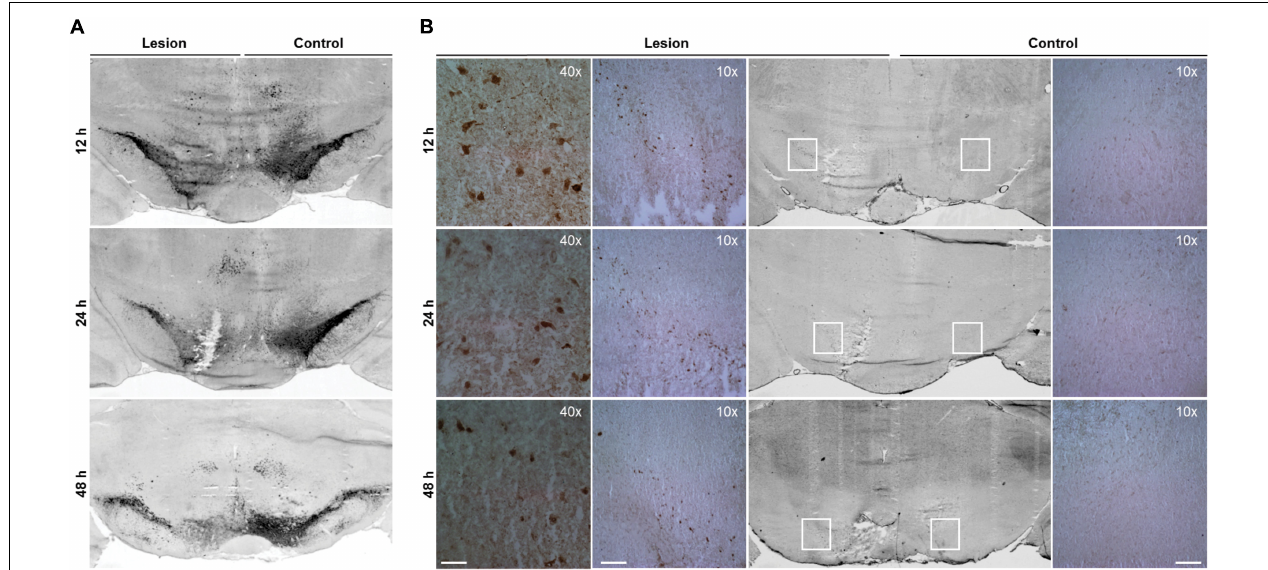
FIGURE 2 | Increased cathepsin X immunoreactivity in the SNc after progressive degeneration of the nigral dopaminergic neurons. Representative immunohistochemical images of coronal midbrain sections of the SNc from the 12, 24, and 48 h time points after 6-OHDA-induced lesion. (A) TH staining demonstrates that the number of TH-positive neurons in the ipsilateral SNc is reduced by 6-OHDA injection (Lesion) at all time points indicated, in comparison to that on the contralateral side (Control). (B) Cathepsin X immunoreactivity in the ipsilateral SNc is increased markedly at 12 and 24 h after 6-OHDA injection (Lesion) compared to the contralateral side (Control). The immunoreactivity of cathepsin X gradually decreases over time; however, the increased expression of cathepsin X is still present 48 h after 6-OHDA injection. For each condition, a group of four animals ( n = 4) was analyzed and four sections of the SNc region of each animal were analyzed. Scale bars = 200 µ m (10 × ), 50 µ m (40 ×